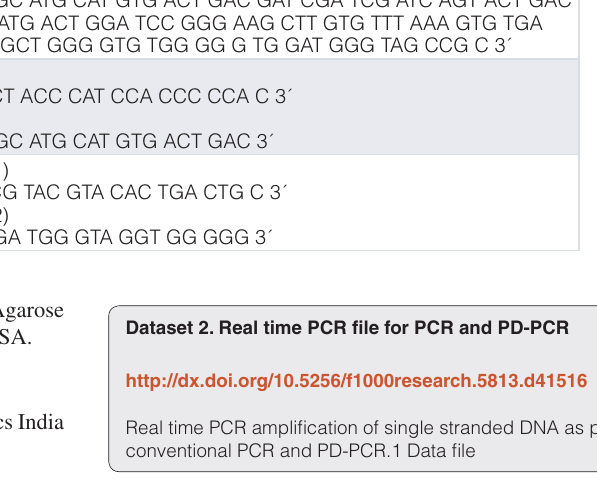
Table 1. Shows sequence of custom synthesized template DNA and oligonucleotide primers used in this study. Sequence of single stranded template DNA